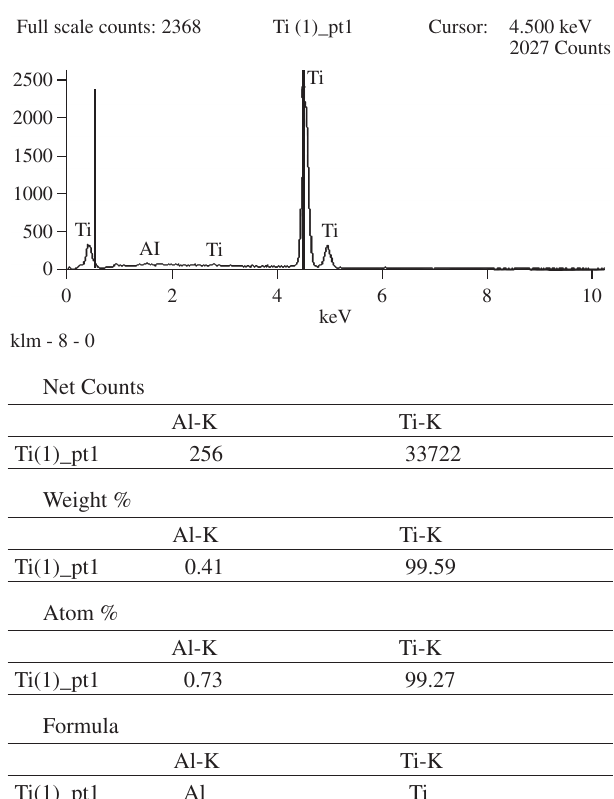
Table 1. Mean values of advancing ( θ hysteresis in the contact angle ( ∆θ = θ